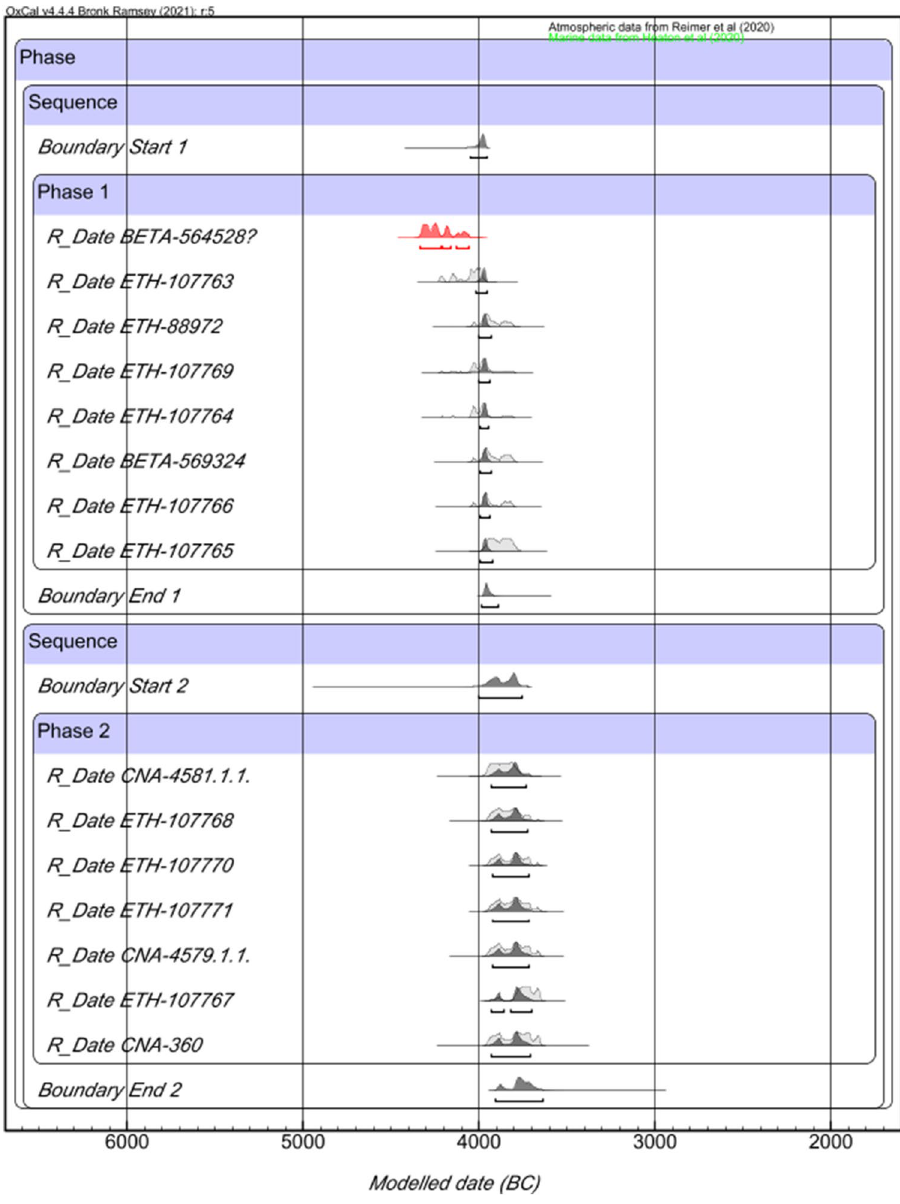
Figure 4. Overlapping Phases, Bayesian Modelling of radiocarbon dates obtained from human bone